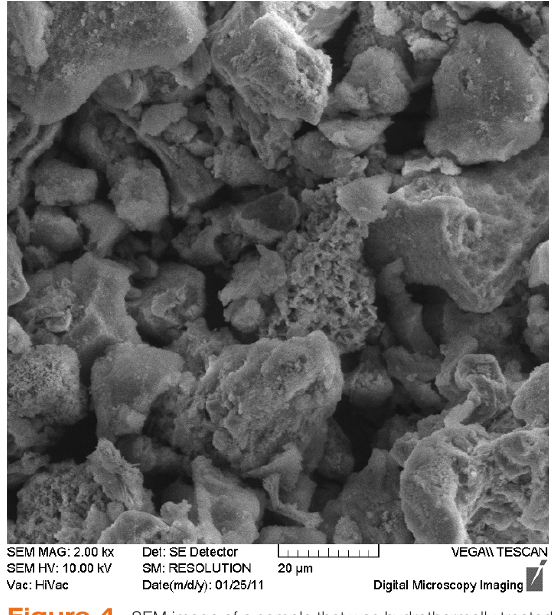
Figure 4. SEM image of a sample that was hydrothermally treated for 2 days.